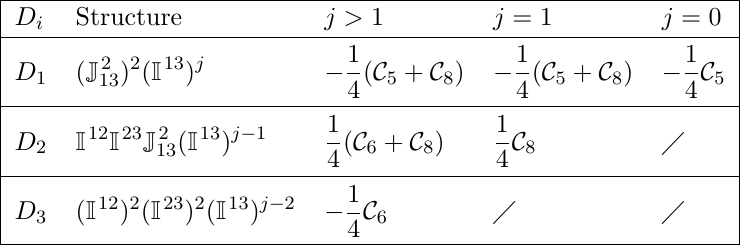
OTO when O has h i